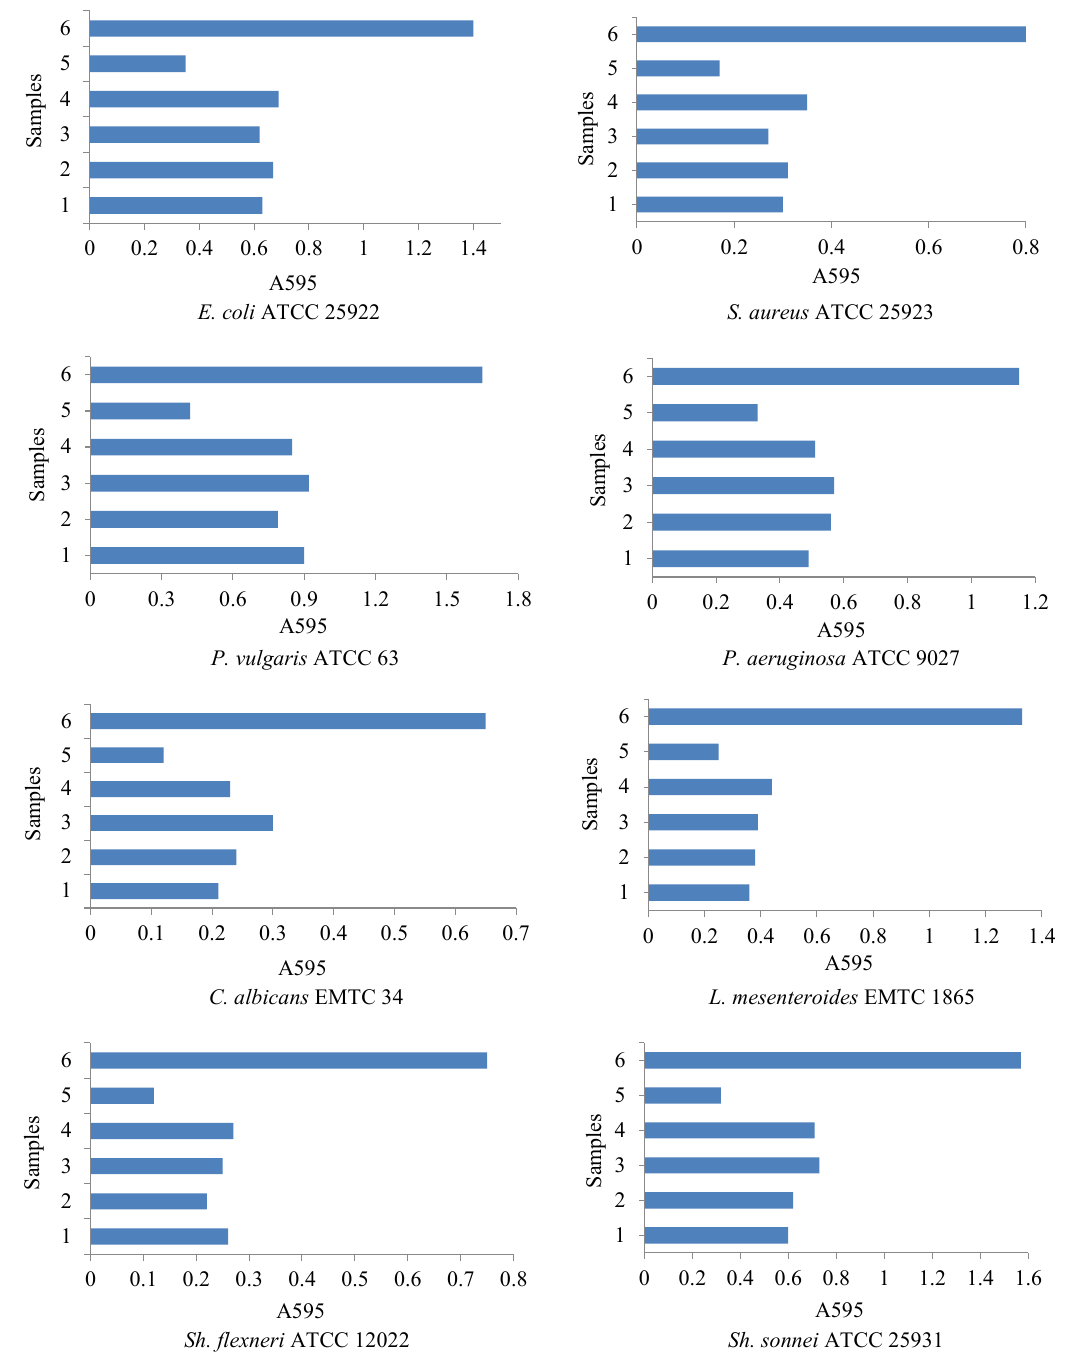
Figure 2 Antimicrobial activity of callus extracts (optical density method): 1 – Eleutherococcus senticosus ; 2 – Codonopsis pilosula ; 3 – Platanthera bifolia ; 4 – Saposhnikovia divaricata ; 5 – ciprofloxacin; 6 –